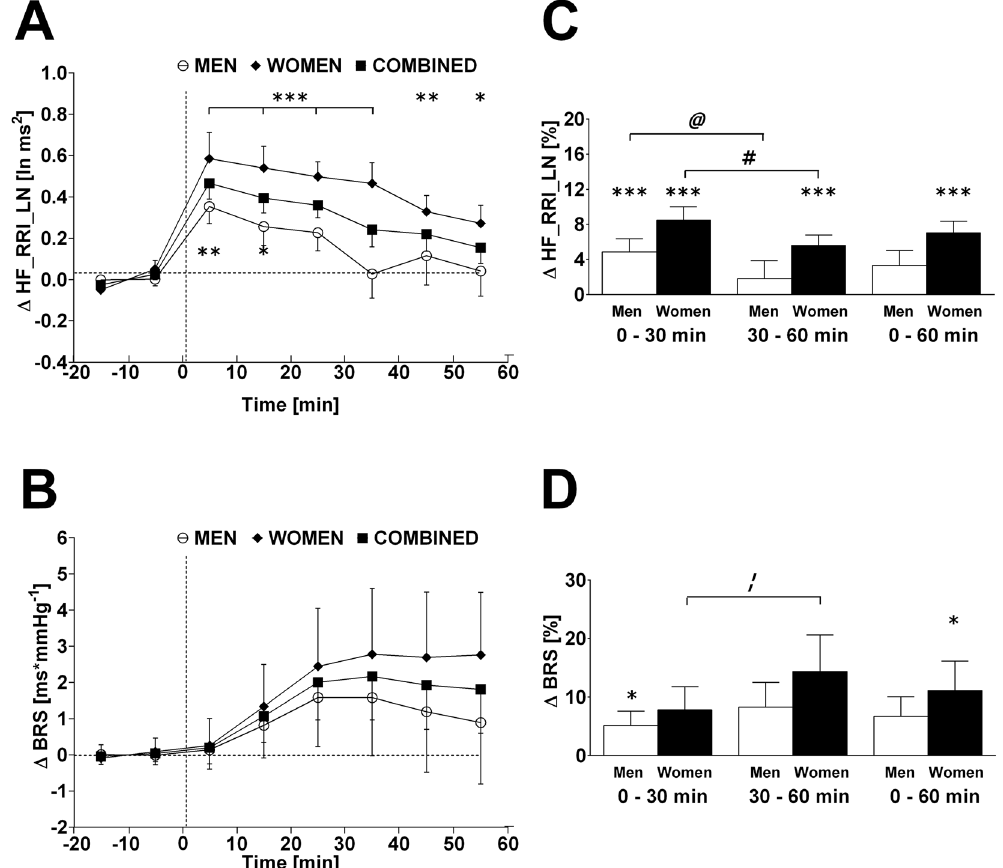
Figure 3. Left panels A and B: Time course of changes ( Δ ) from baseline in high frequency component of RR-interval (HF_RRI_LN) and baroreflex sensitivity (BRS), respectively. Open circle ( ○ ) = men; closed diamond ( ♦ ) = women; closed square ( ■ ) = combined men and women. Right panels C and D represent mean percentage changes in HF_RRI_LN and BRS relative to baseline. Time 0 denotes four minutes after the water drink with calculating a subsequent average over the following 30 minutes, 30 to 60 minutes, and 0 to 60 minutes post-drink, respectively, which were subtracted from each baseline level and presented as deltas. * P < 0.05, ** P < 0.01 and *** P < 0.005 statistically significant differences over time from baseline values (left and right panels). # P < 0.005, @ P < 0.01, and ¦ P < 0.05 statistically significant difference between 0–30 min and 30–60 min post-drink periods (right panel). All values are reported as means ±